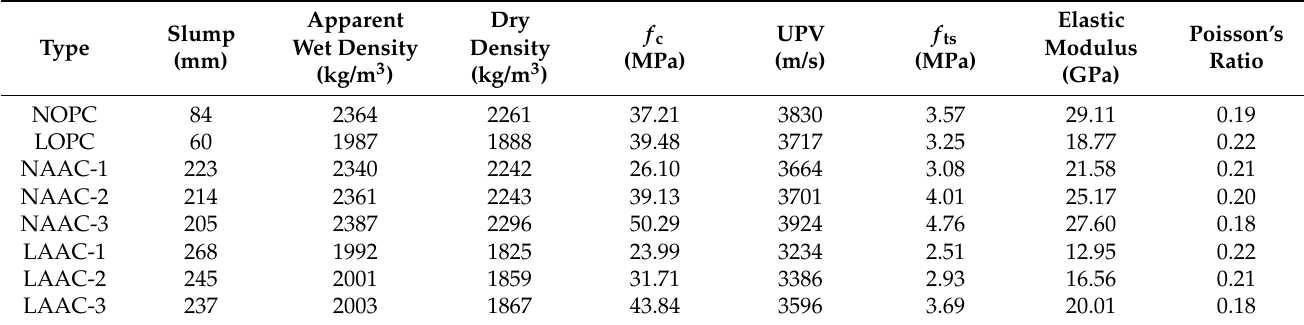
Table 5. Basic properties of the mixtures.